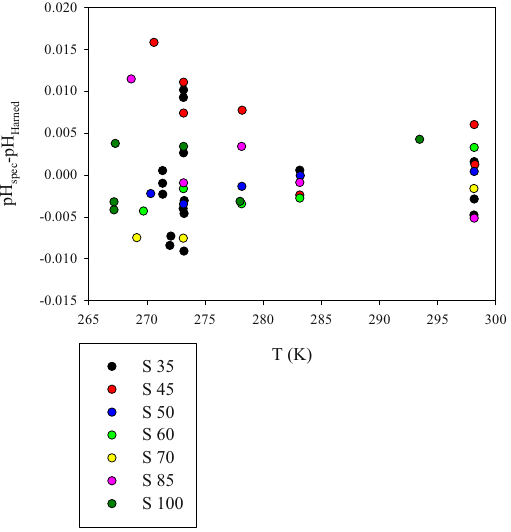
Figure 7. Differences between spectrophotometrically (equations 4, 6, 7 and 8) and electrochemically (Harned) determined pH T in Tris/HCl buffer solutions in synthetic seawater and brines with conservative (seawater- derived) major ionic